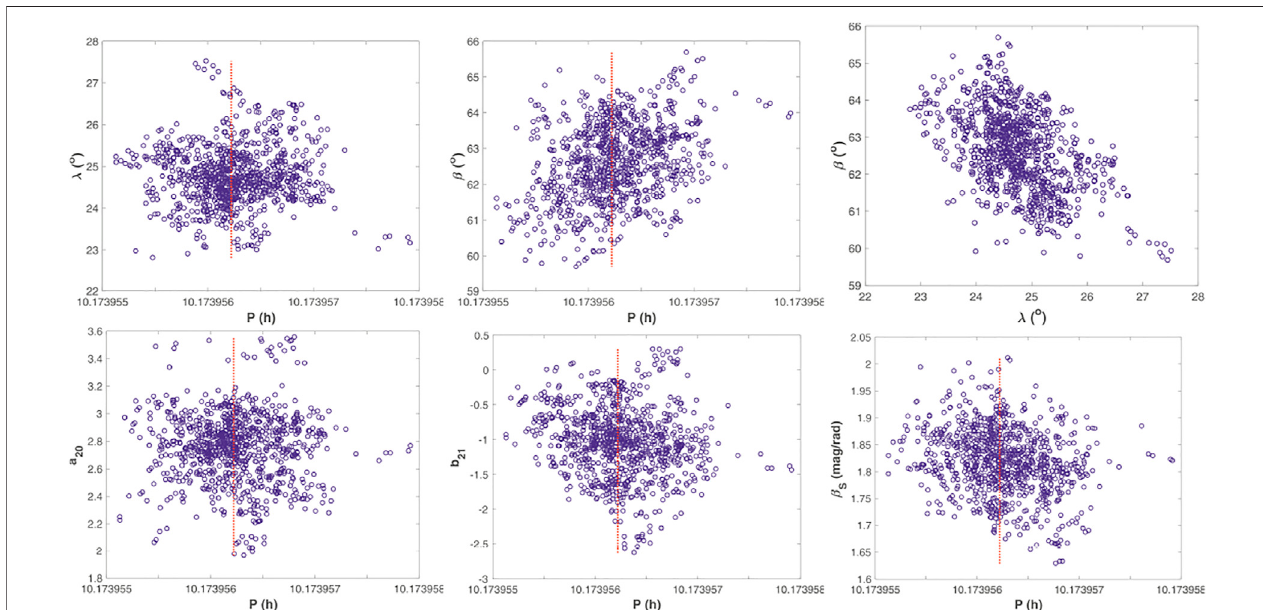
FIGURE 10 | MCMC sampling of the rotational, shape, and photometric phase-curve parameters for the GS-asteroid simulation in the case of relative lightcurves. Themarginalprobabilititydensitiesarecharacterizedbyanunbiasedsub-sampleof1,000parametersetsselectedfromthecomplete sampleof30,000sets.Wedepict rotationalpolelongitude( λ )andlatitude( β )vs.rotationperiod( P ;uptotheleftandmiddle,respectively),polelongitudevs.polelatitude(uptotheright),examplespherical harmonics coef fi cients a 20 and b 21 vs. rotation period (down to the left and middle, respectively), and photometric slope ( β S (20 ° )) vs. rotation period (down to the right). The red, dotted line marks the true rotation period.